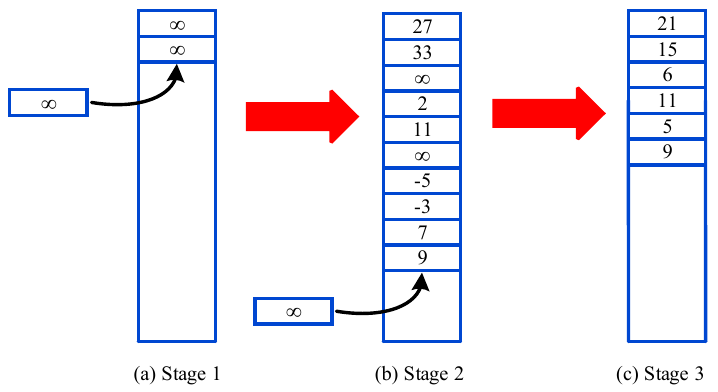
Figure 3. Implementation of memory optimization for the replay buffer.